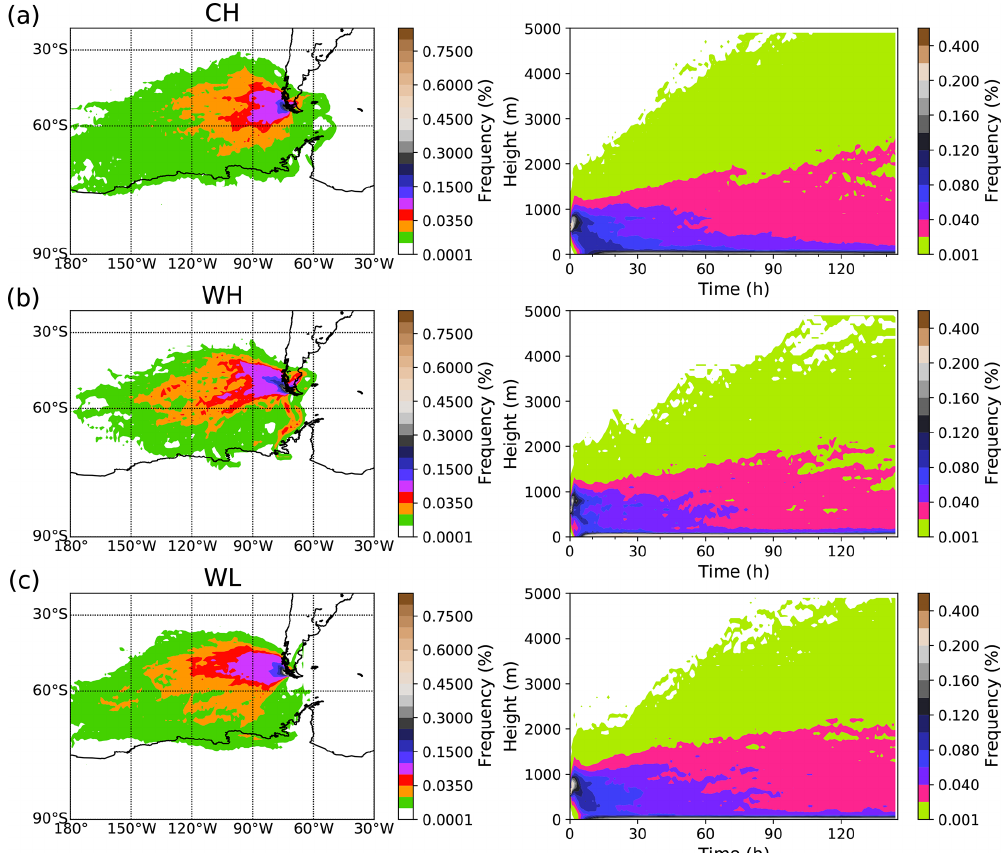
Figure 11. Relative frequency of backward trajectories ending at Cerro Mirador site (600ma.s.l.) with 1 h resolution, based on a 1 ◦ by 1 ◦ grid size (left) and the corresponding relative frequency of backward trajectory height (right) during cold season high (CH, a ), warm season high (WH, b ), and warm season low (WL, c